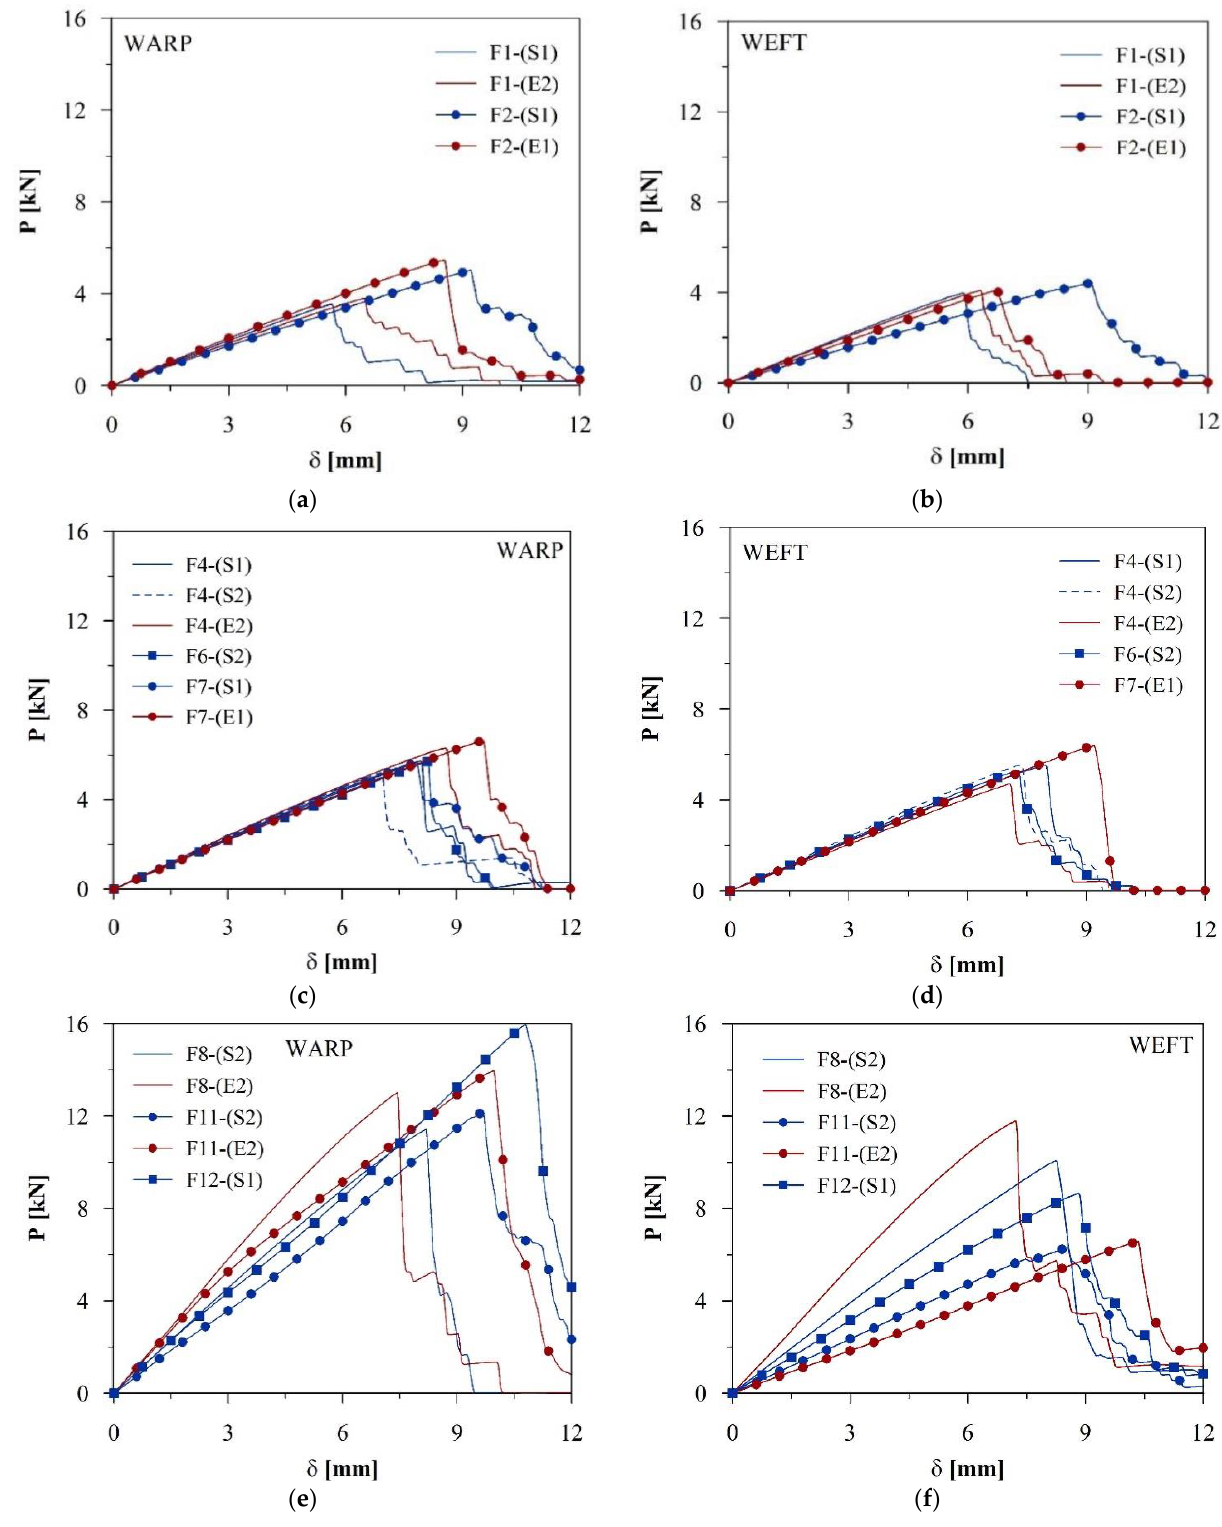
Figure 3. Examples of average load vs. displacement response curves for the investigated textiles in the warp and in the weft direction: low ( a – b ), medium ( c – d ), and high warp grammage textiles ( e – f ).